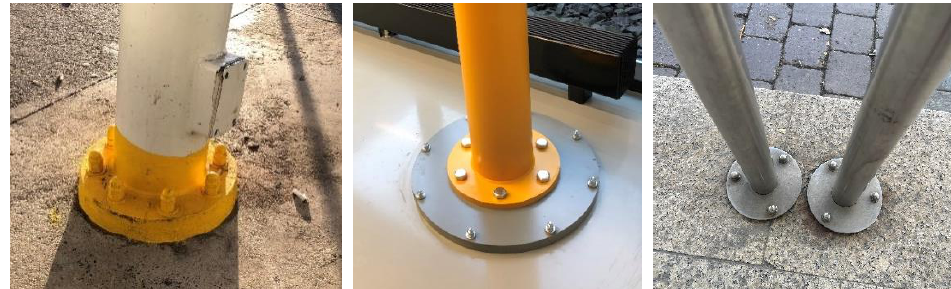
Figure 1. Examples of non-rectangular anchor groups used in practice (photos by author).